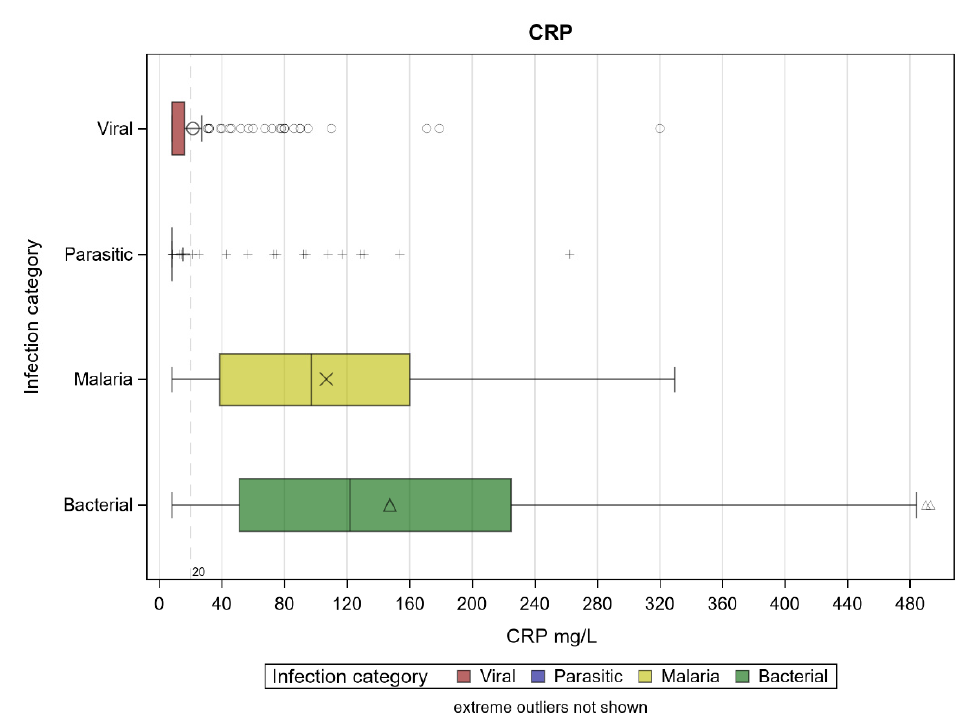
Figure 2. CRP levels according to infection category. Extreme outliers are not shown.